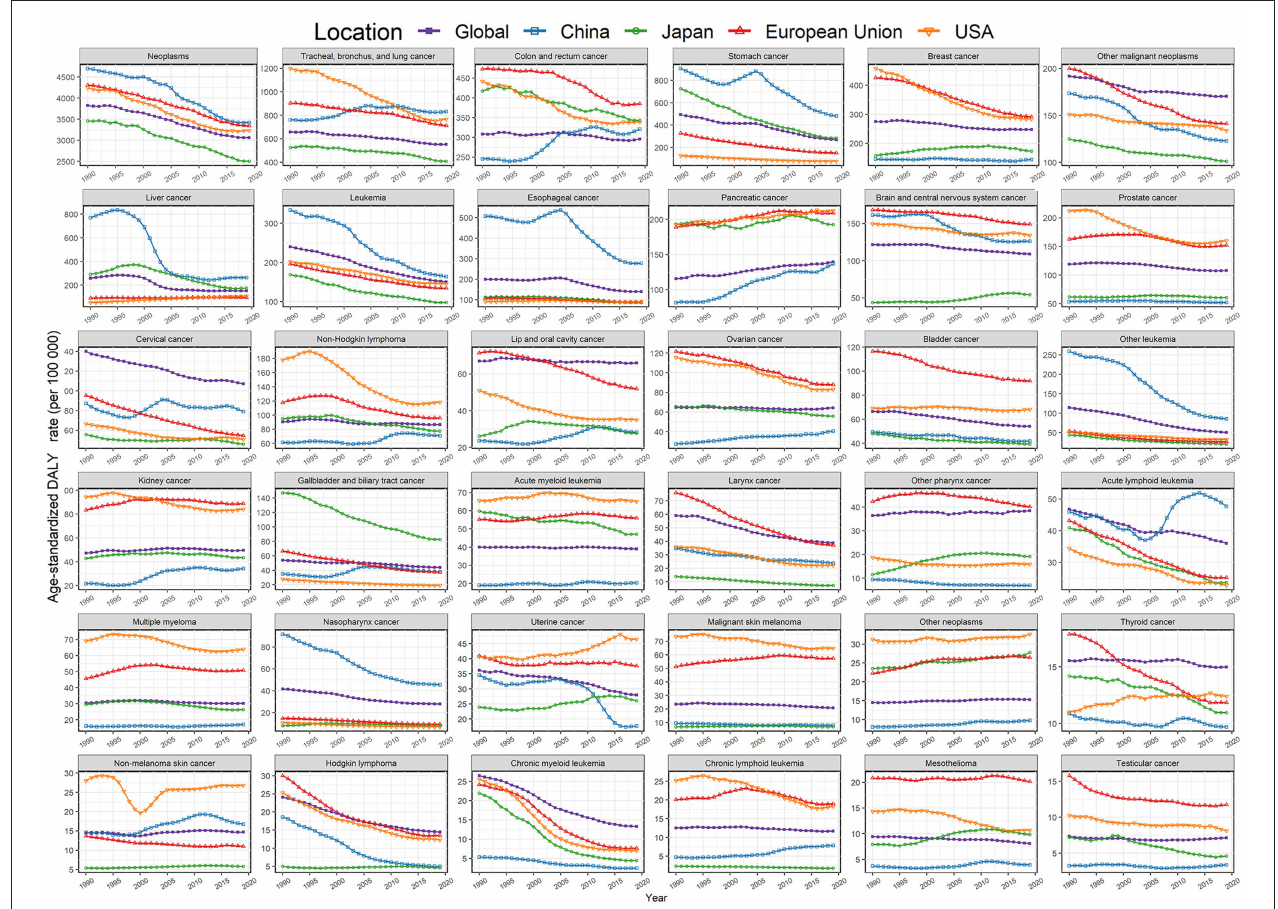
FIGURE 3 | Trends for the ASDR of 36 neoplasm types in the world, China, Japan, European Union, and USA from 1990 to 2019,